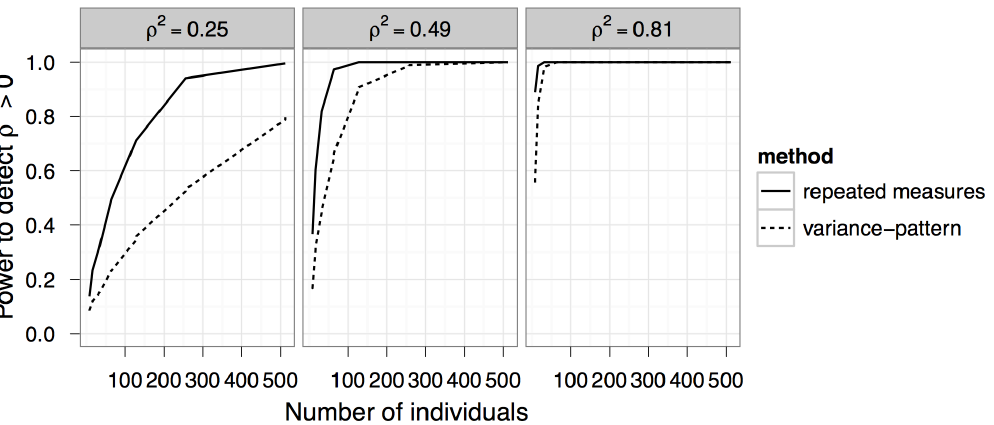
Figure 4. Power comparison with repeated-measures approaches. Our method for detecting growth autocorrelation (dotted line) is less powerful than exact restricted likelihood ratio tests on linear mixed models fit to data on marked individuals (solid line).